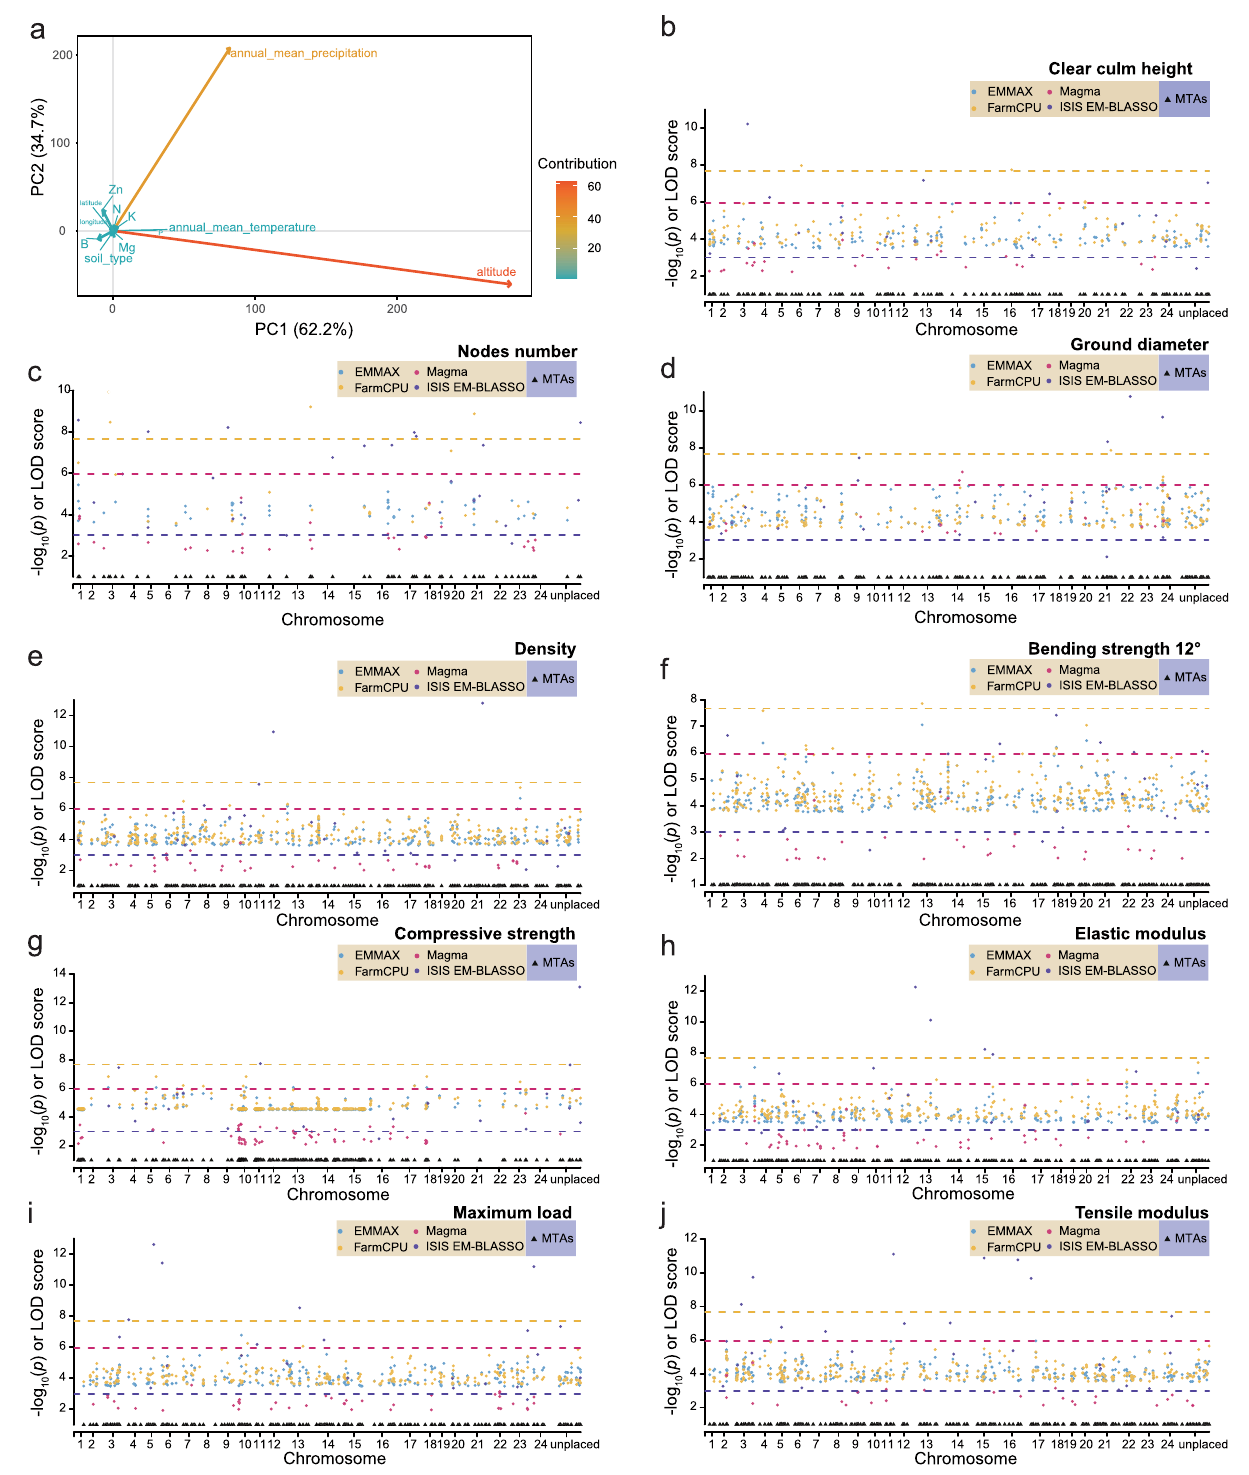
Fig. 4 GWAS of important property traits. a Principal component analysis (PCA) of 12 environmental factors in which the depth of color represents the contribution of the variable. b – j Manhattan plot of marker-trait associations (MTAs) identi fi ed using statistical approaches for nine traits, including a clear culm height, node number, ground diameter, density, bending strength (12°), compressive strength, elastic modulus, maximum load, and tensile modulus. The statistical approaches include EMMAX, ef fi cient mixed-model association expedited; FarmCPU, fi xed and random model circulating probability uni fi cation with high statistical power; Magma, gene-level association; ISI EM-BLASSO: based multi-locus association. The p -value threshold was 2.10 × 10 − 8 , 2.10 × 10 − 8 , and 1.08 × 10 − 6 for EMMAX, FarmCPU, and Magma by Bonferroni correction method, separately. The log of odds (LOD) threshold for ISIS EM-BLASSO method is 3 as suggested. For simplicity and clarity, only candidate SNPs were plotted. The MTAs are indicated by black triangles in the lower part of the fi gure. Source data are provided as a Source Data fi